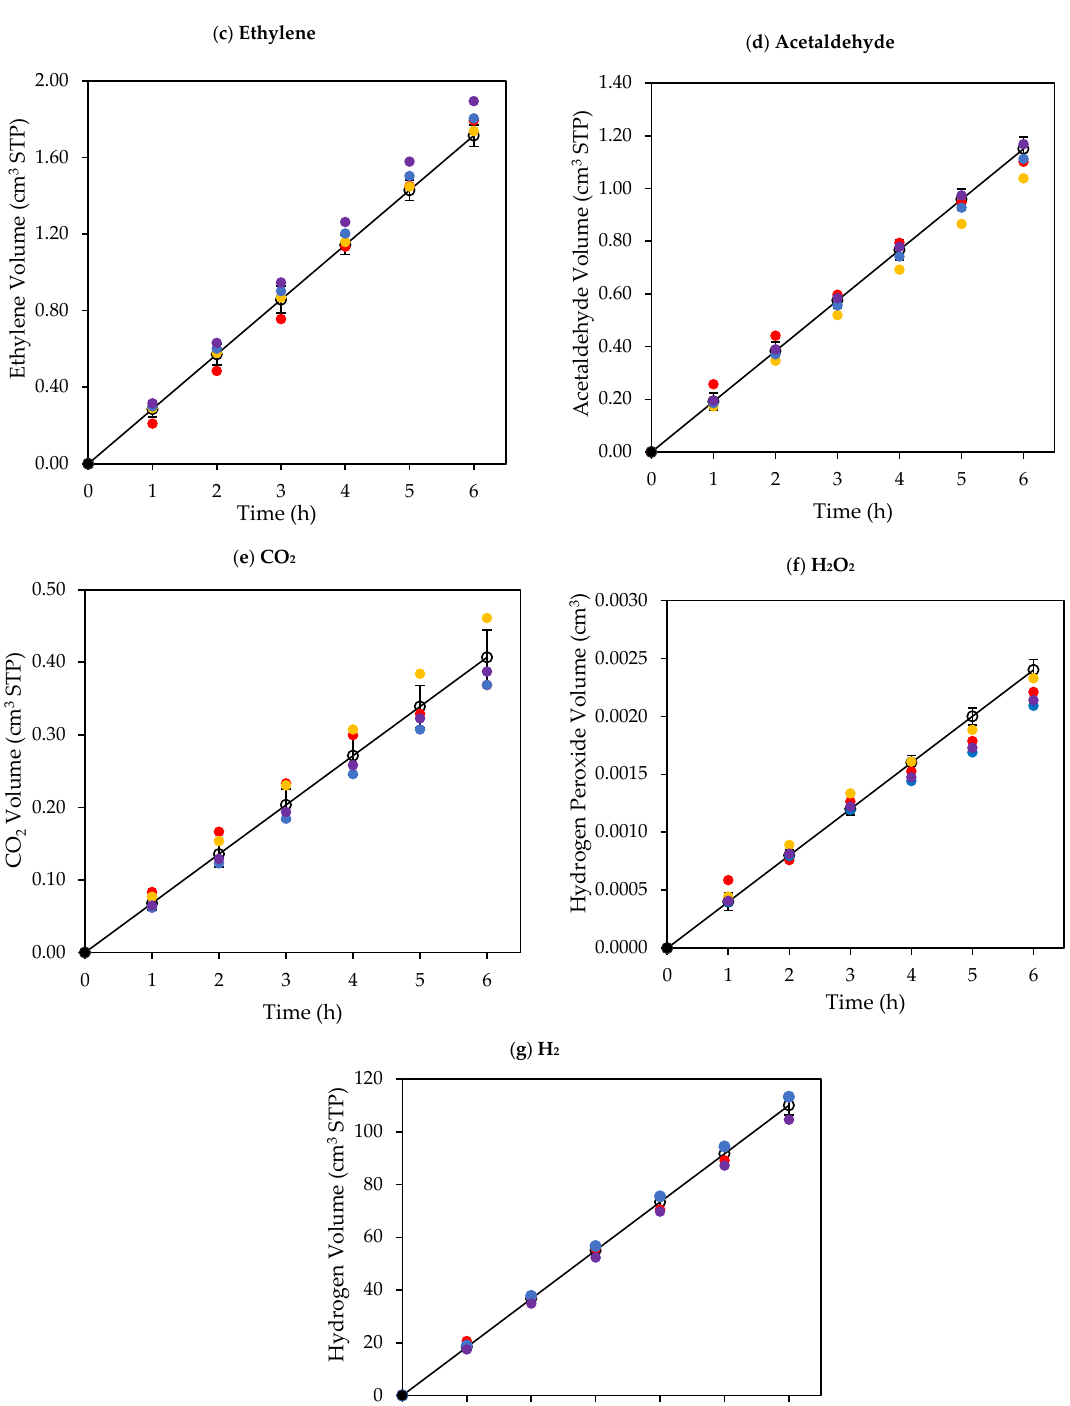
Figure 8. Cumulative chemical species volumes obtained under near-UV: ( a ) methane; ( b ) ethane; ( c ) ethylene; ( d ) acetaldehyde; ( e ) CO 2 ; ( f ) H 2 O 2 ; and ( g ) H 2 . Experimental data are represented by ( ) filled with different colors, each color represents a different experimental run, and model (cid:35) predictions are represented with solid lines. Experimental conditions: 0.25 wt% Pd-TiO 2 ; 0.15 g L − 1 photocatalyst concentration; initial pH = 4.0 ± 0.05; and 2.0 v / v %